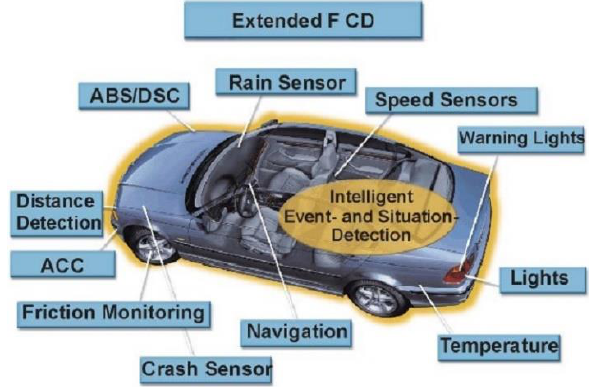
Figure 4. Embedded sensors in floating cars